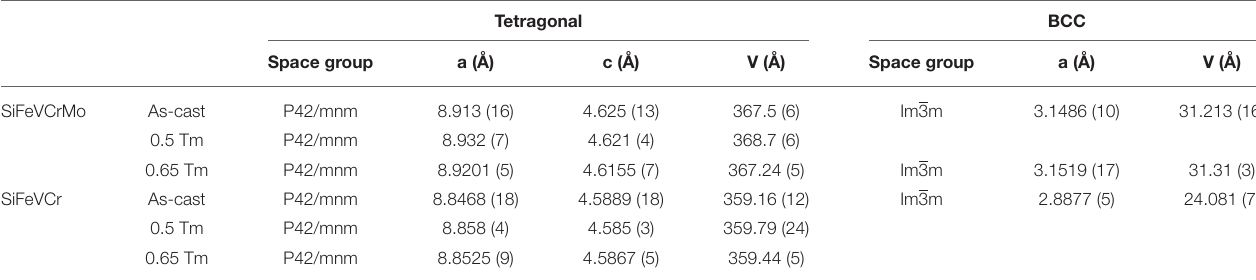
TABLE 2 | Refined structural parameters obtained from standard least squares